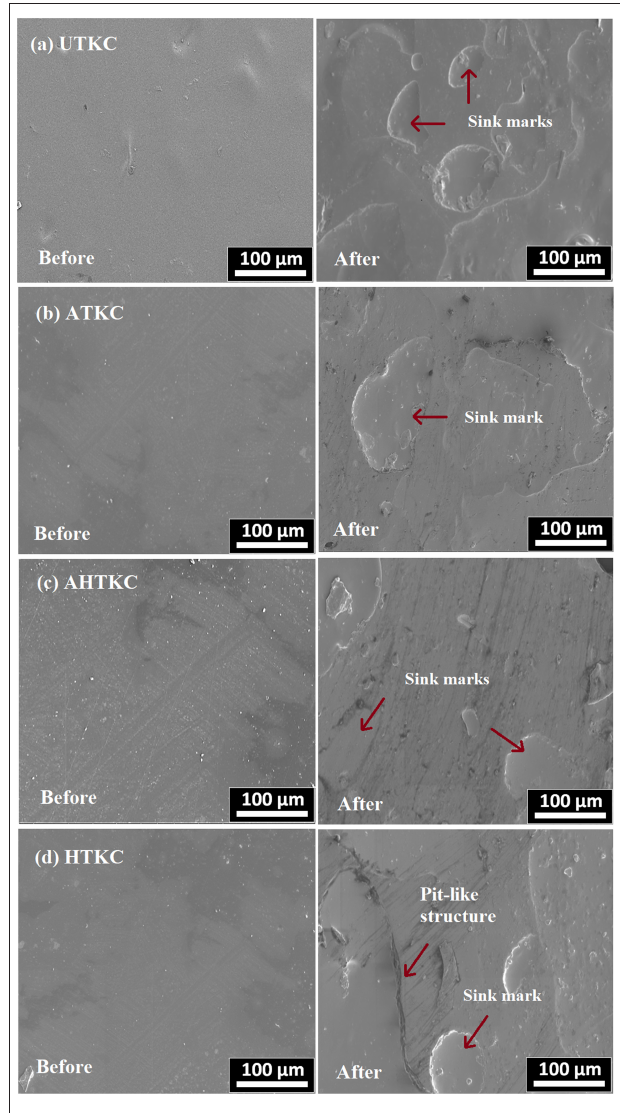
FIGURE 5 | SEM images of surface appearance before and after weathering test for (a) UTKC, (b) ATKC, (c) AHTKC, and (d)